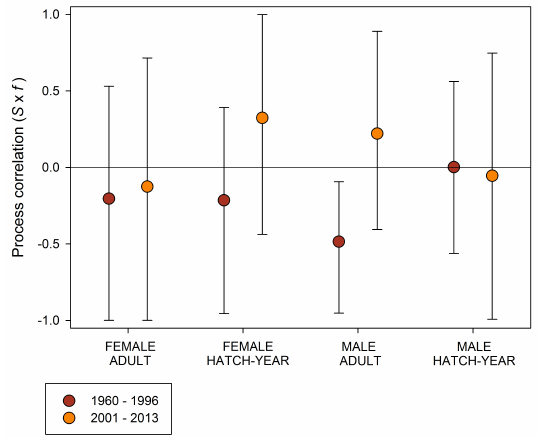
Fig. 10. Estimate of process correlations ( ρ , 90% minimum credible intervals) between annual survival rates ( S ) and annual recovery rates ( f ) for Northern Pintail ( Anas acuta ) banded in southern Alberta and Saskatchewan, Canada (≤ 54° N latitude) from 1960–1996 and